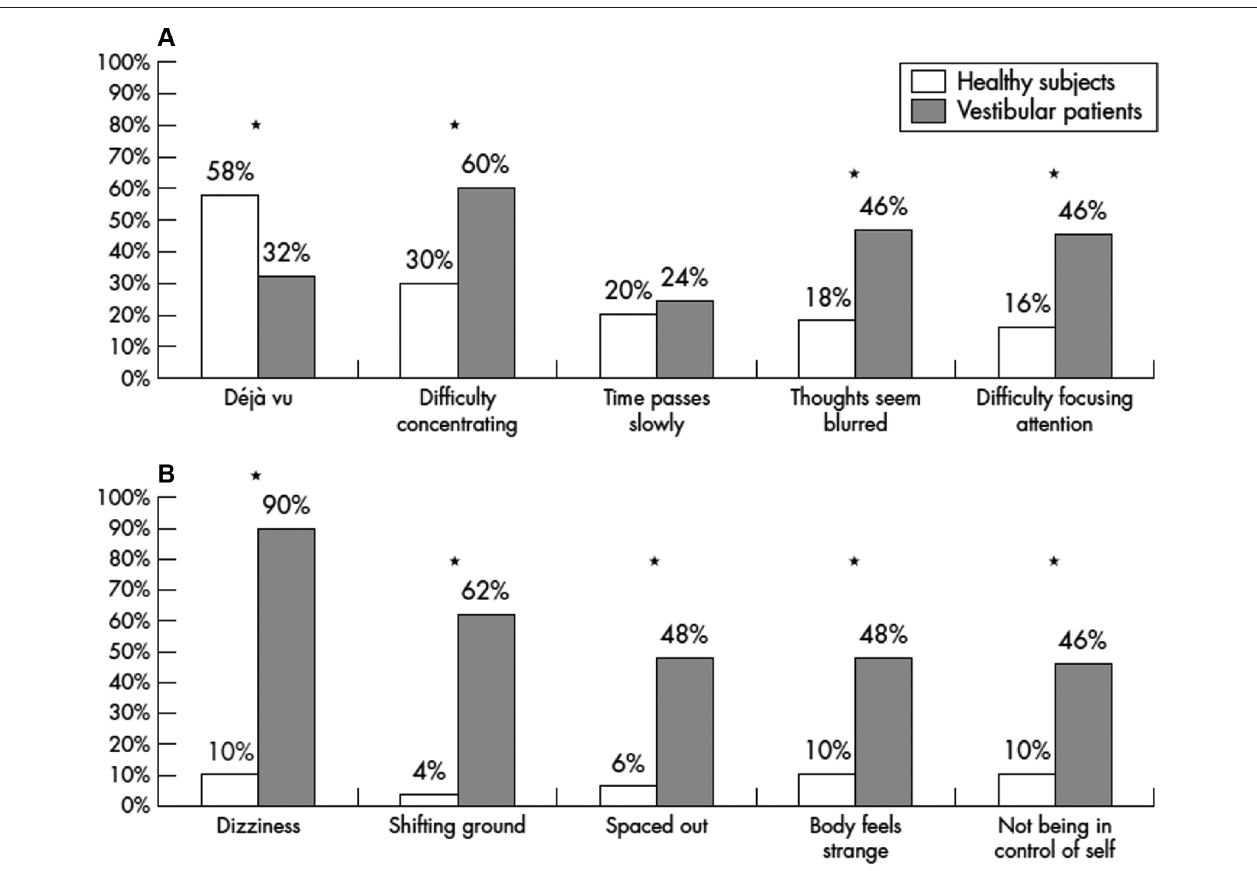
FIGURE 1 | Percentage of vestibular patients and healthy controls reporting the five most frequent depersonalization and derealization symptoms. Reproduced from Sang et al. (2006) with